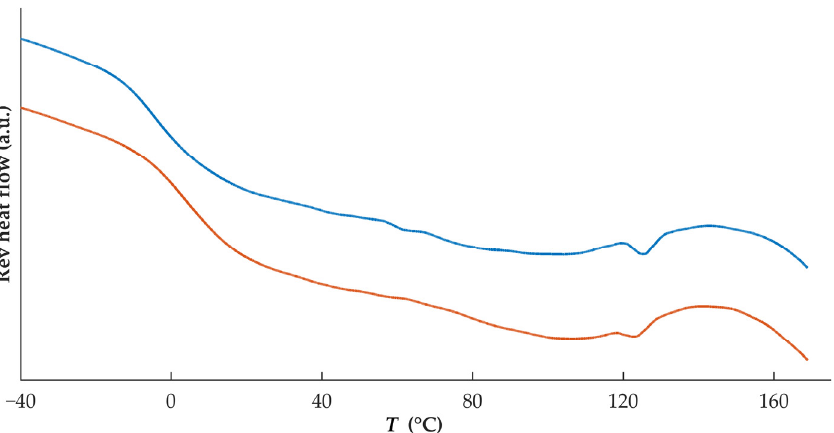
Figure 7. Thermograms of DZP-loaded filament (blue) and tablet (orange) after 1 month of storage at 40 °C/75% RH.